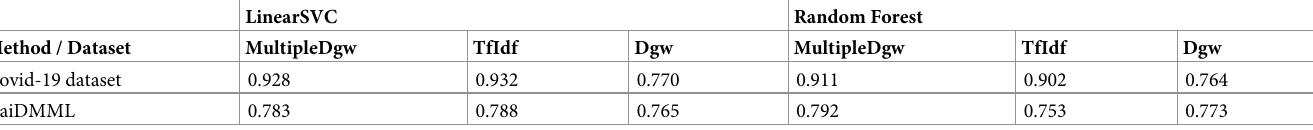
Table 3. Accuracy of classification (classification method /